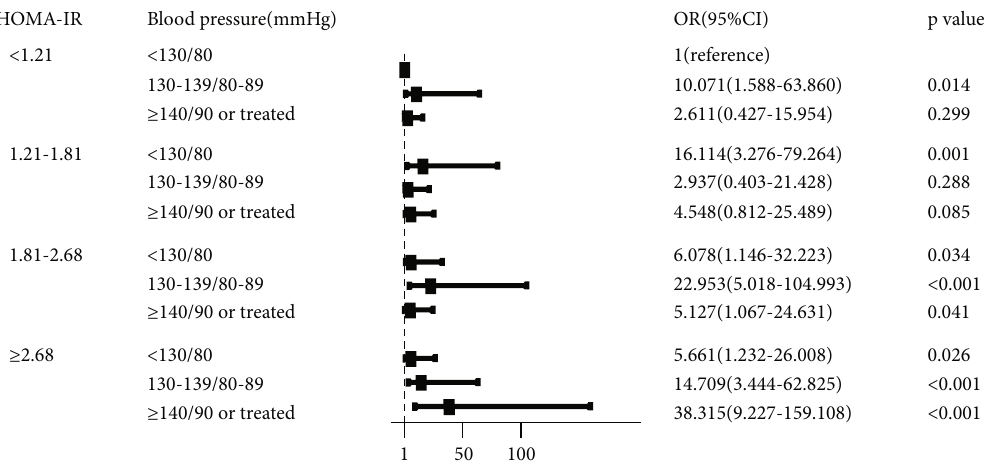
Figure 1: The association between HOMA-IR, BP, and newly diagnosed type 2 diabetes.